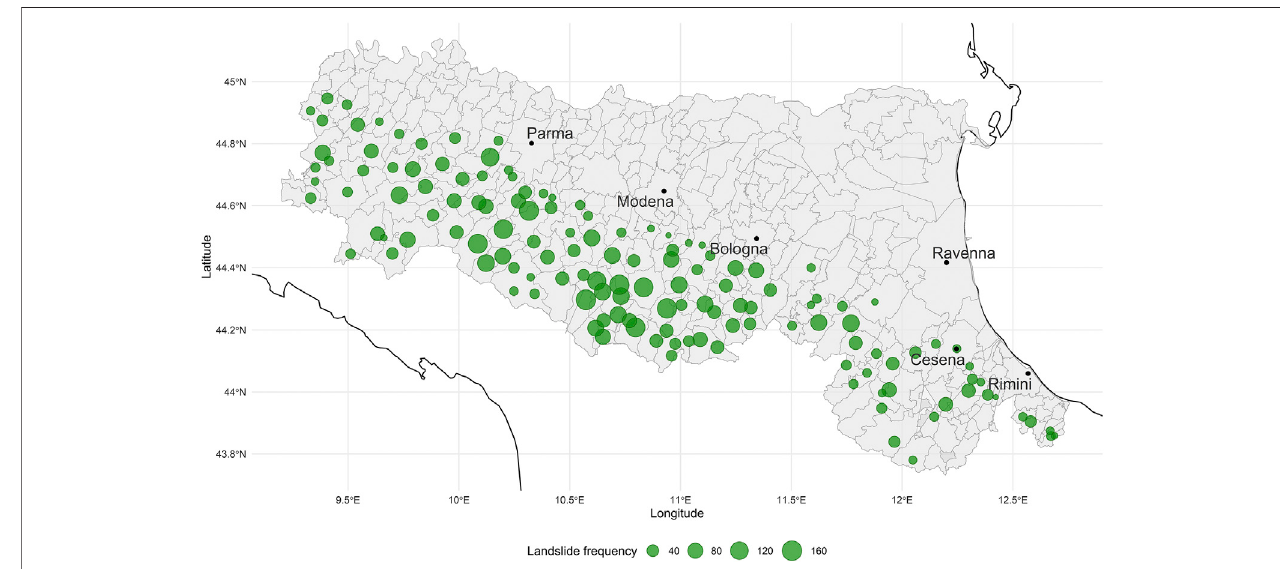
FIGURE 4 | Landslide locations 1981 – 2018 in the region of Emilia-Romagna. Municipality boundaries are shown in black.